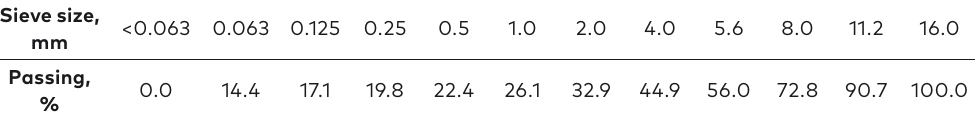
Table 3. Gradation table for BBTM 11A PMB 45/80-55